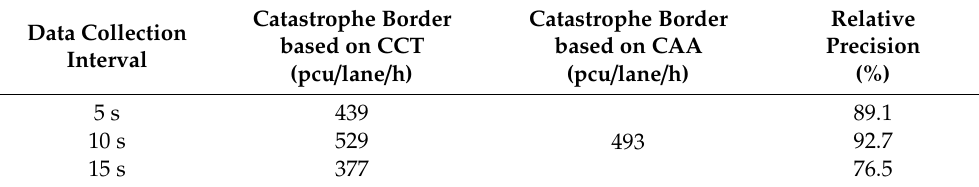
Table 6. Model at di ff erent data collection intervals based on cusp catastrophe